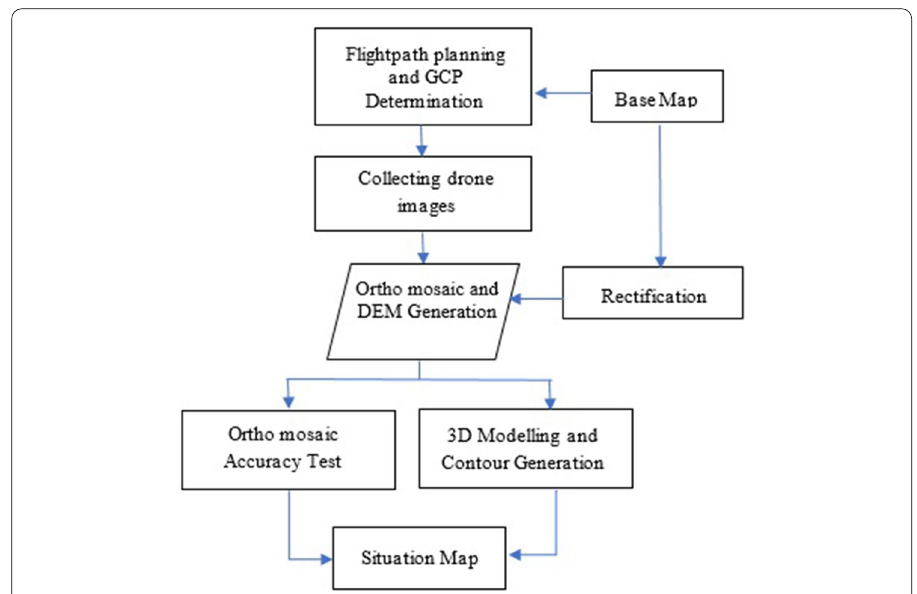
Fig. 3 Research methodology